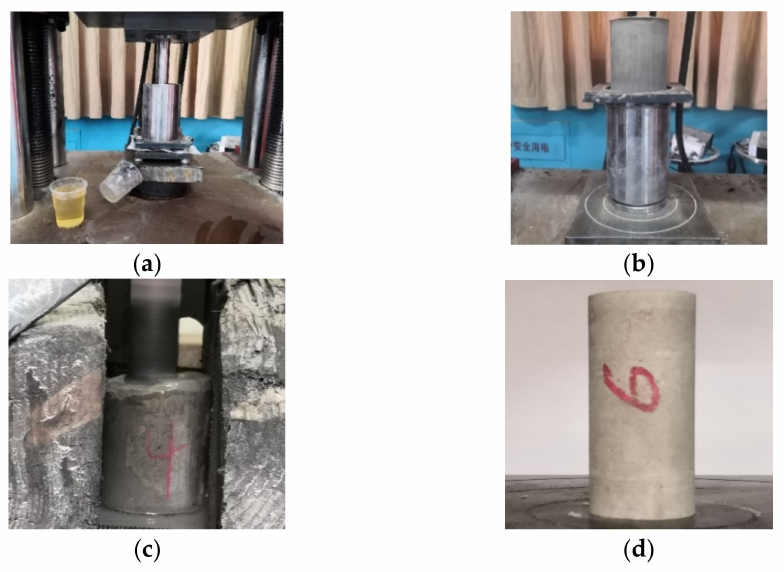
Figure 7. Test process of filter cake specimens: ( a ) curing pressure process; ( b ) demolding of filter cake; ( c ) drilling sampling; ( d ) cylinder